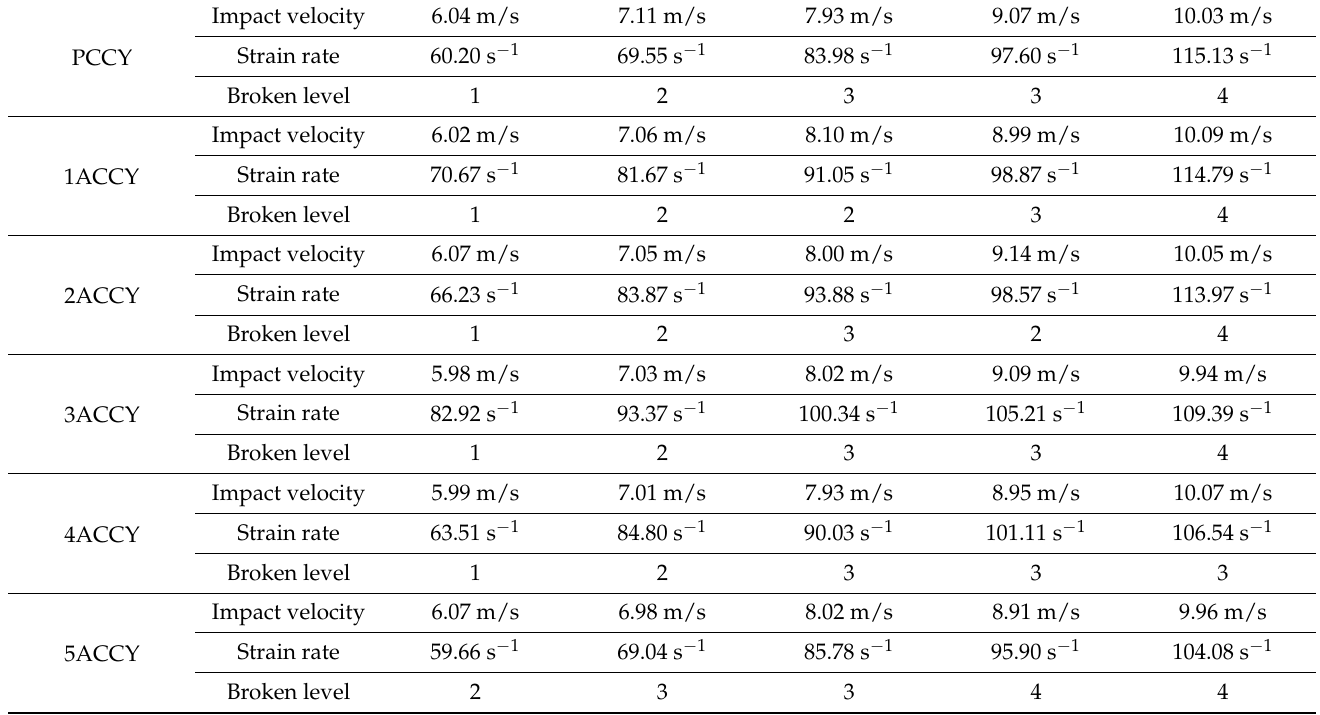
Table 2. Breakage grade of specimen after impact